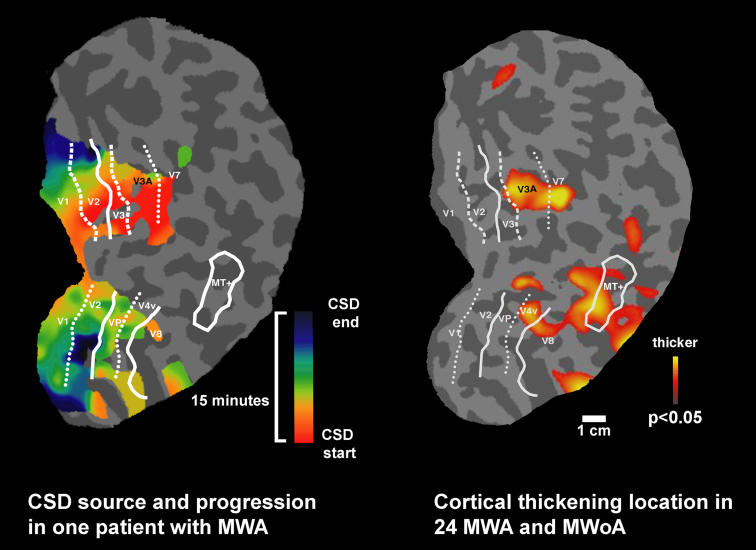
Retinotopic Localization of Cortical Thickness ChangesFlattened maps of the right occipital cortex, gyri, and sulci are indicated as light and dark gray. The borders of retinotopic areas are indicated in white (horizontal meridians, solid lines; upper vertical meridians, dotted lines; lower vertical meridians, dashed lines). The image on the left is taken from our previous data [29] and shows the progression of CSD during a visual aura, starting in area V3A, in a single participant. The image on the right shows the average map of the mean thickness difference of 24 migraineurs compared with 15 matched controls, projected on the same brain, with the superimposed retinotopy for one participant. A clear correspondence can be seen between the area of CSD origin in V3A in the left image and cortical thickness difference in the right image. In addition, areas of thickening can be observed in visual area MT+.